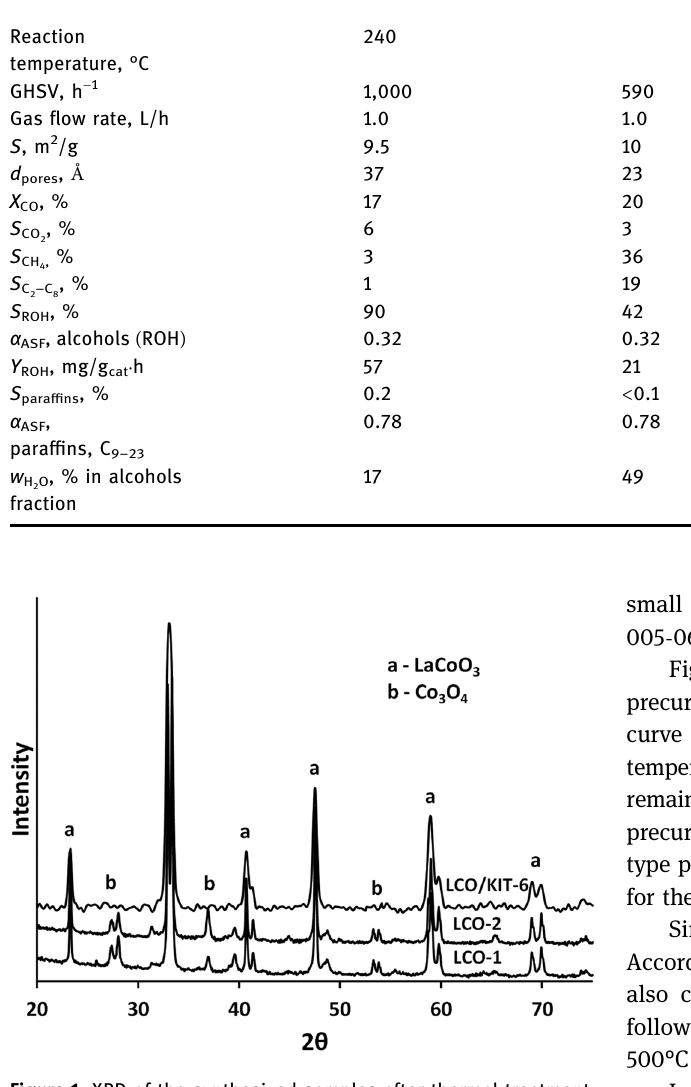
Figure 1: XRD of the synthesized samples after thermal treatment at